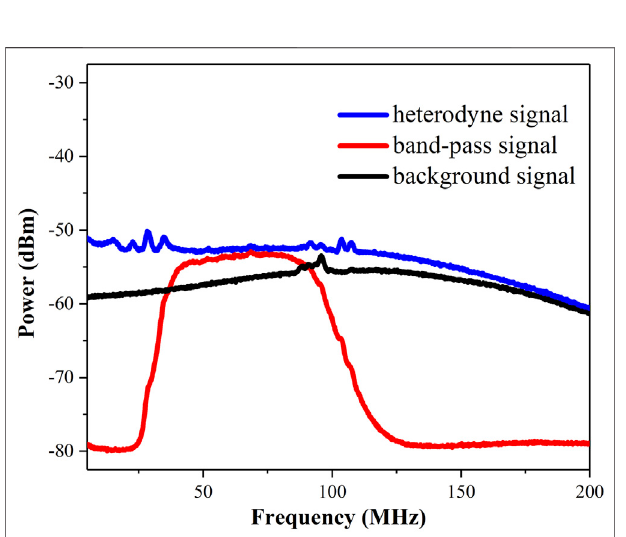
FIGURE 5 | Plots of measured system total noise density, laser-induced noise density, detection noise density, laser-induced shot noise density, and laser relative intensity noise density versus LO injection current,